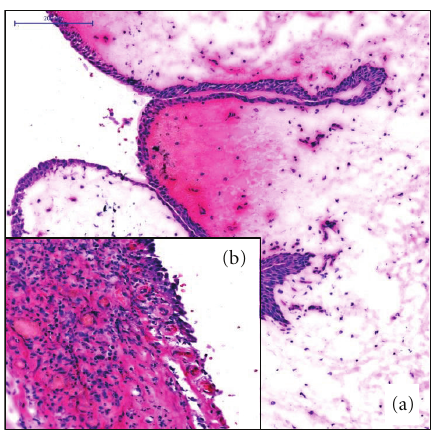
Figure 4: HE staining showing a fibroepithelial polyp with covering urothel (a), some erosion, and inflammation (b), but no atypia or